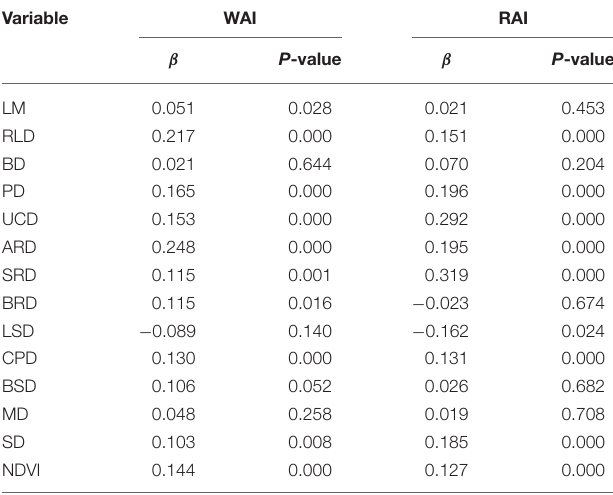
TABLE 5 | The results of MLR-LT regarding WAI and RAI. Variable